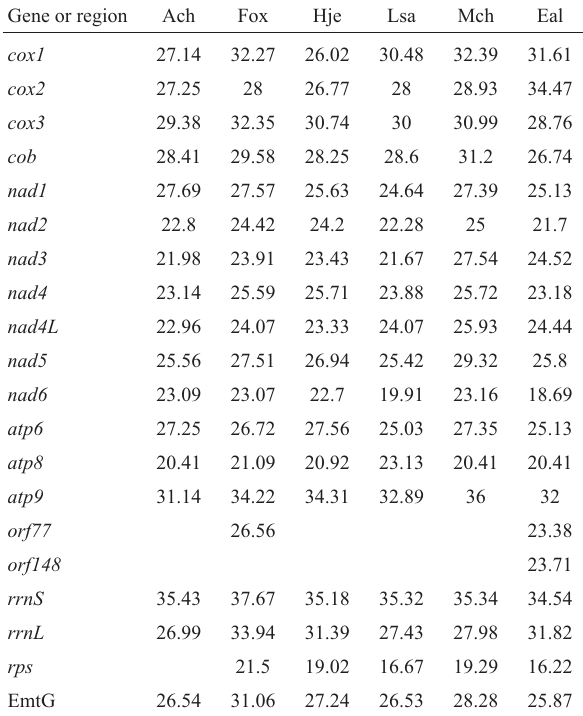
Table 4 - Comparison of G + C content (%) of the protein-coding and rRNA genes of mitochondrial genomes of Hypocreales